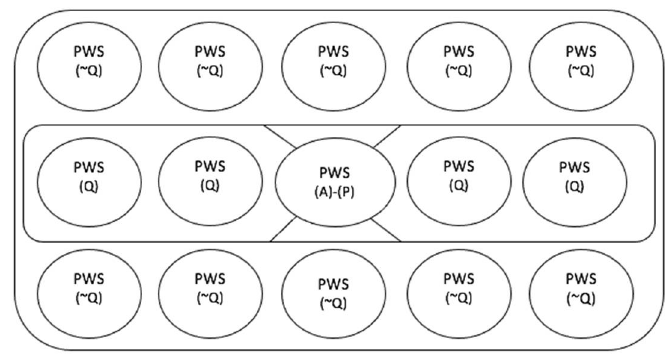
Figure 1. System of Possible World-States (1).